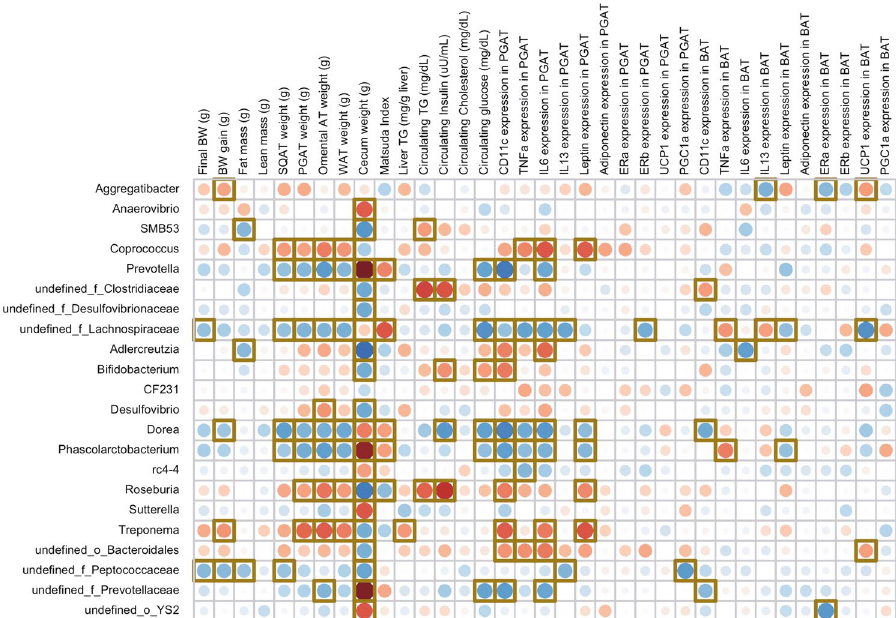
Figure 7. Correlations among differentially abundant taxa within the cecal microbial community identified through MaAsLin analysis and physiological parameters and gene expression data. Red dots represent positive correlations whereas blue dots represent negative correlations; yellow square box denotes statistical significance ( p < 0.05) observed using Spearman